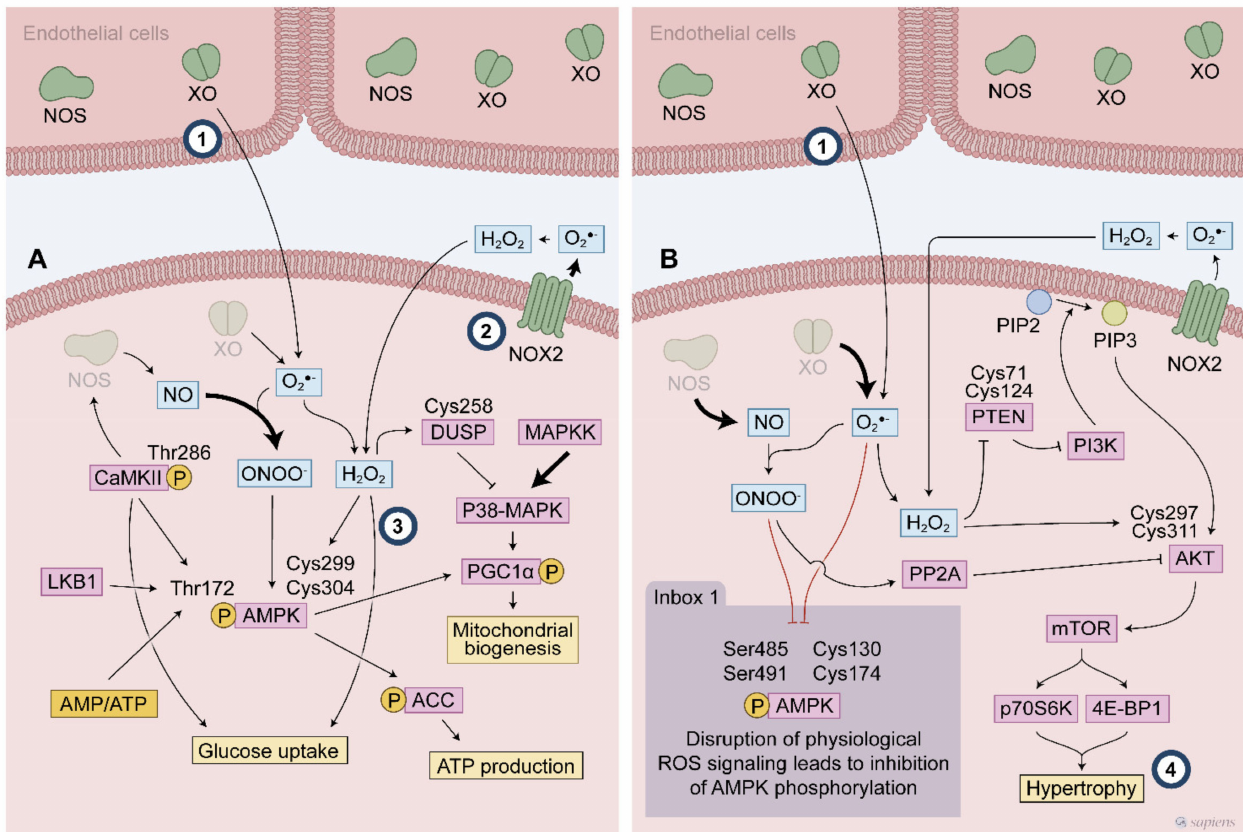
Figure 4. Exercise-generated ROS affect redox sensitive protein activated following endurance ( A ) and resistance exercise ( B ). During endurance exercise, the ROS mediated signaling activates multiple cascades such as P38 MAPK and AMPK to promote the exercise responses. ROS modify specific cysteines leading to AMPK phosphorylation at Thr172. AMPK activation is described to promote many exercise responses, such as glucose uptake and mitochondrial biogenesis. Dual- specificity phosphatase (DUSP) cysteine modifications is a possible target of ROS to control P38 MAPK signaling during exercise. High intensity exercise recruits many different ROS sources that contribute to this ROS mediated signaling. ROS participates of PI3K activation through both a direct mechanism involving AKT activation and an indirect mechanism by attenuation phosphatase activities (e.g., PP2A and PTEN), then favouring the hypertrophy signaling. Inbox: Thr 172 AMPK phosphorylation is blunted by disrupted ROS signaling where either an excessive or blunted ROS production alters the expected AMPK activation following exercise. (#1–4 indicates knowledge gaps. #1 indicates the debated topic about XO location. #2 the main source of ROS in contracting muscle. #3 the need to uncover the mechanisms by which exercise stimulates glucose uptake and #4 the involvement of PI3/Akt as a redox sensitive cascade to promote